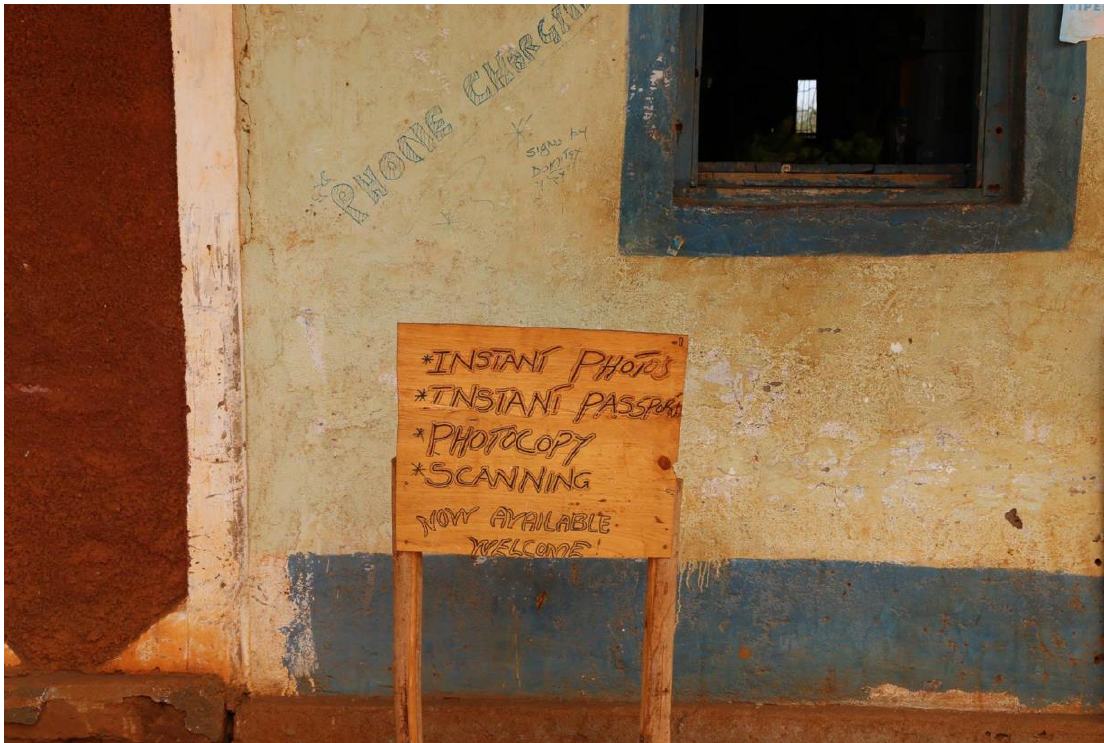
Figure 5. New services provided in Kitonyoni following electrification. The sign reads “Instant photos, Instant passport [photos], Photocopy, Scanning Now Available. ” .